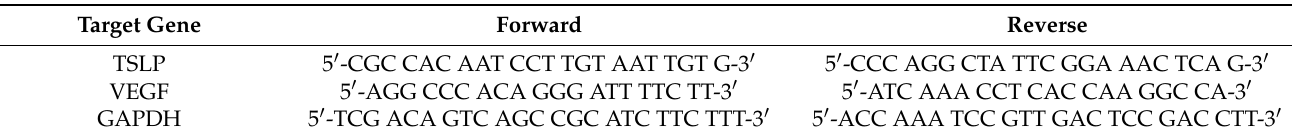
Table 1. The sequences of